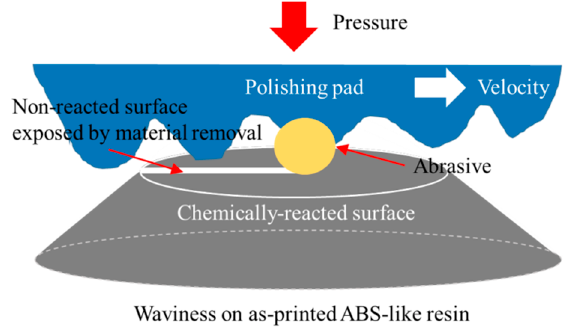
Figure 7. Schematic diagram of ABS-like resin CMP in one-step polishing.